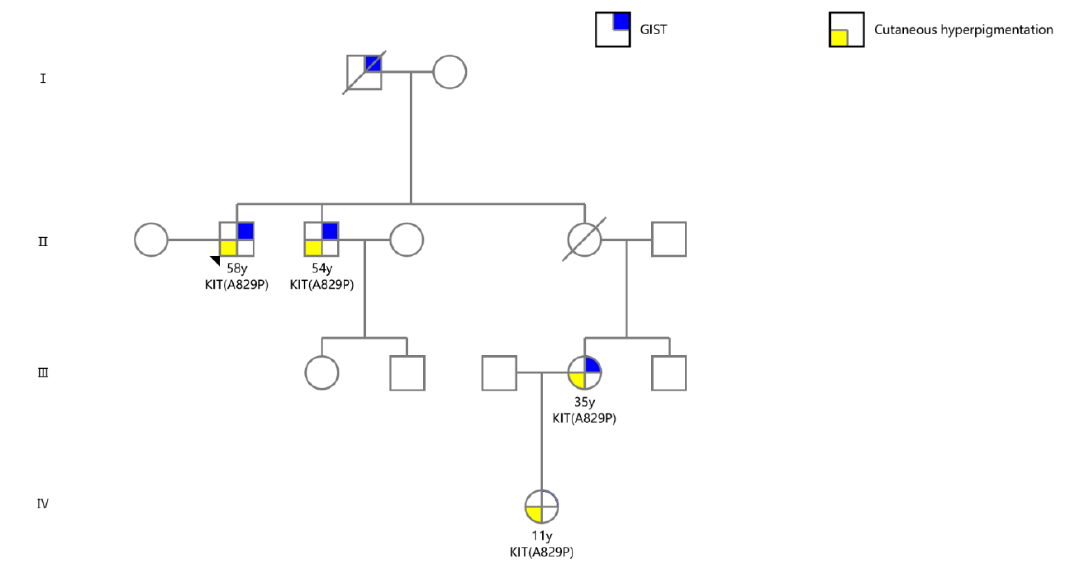
Figure 3. The family pedigree.